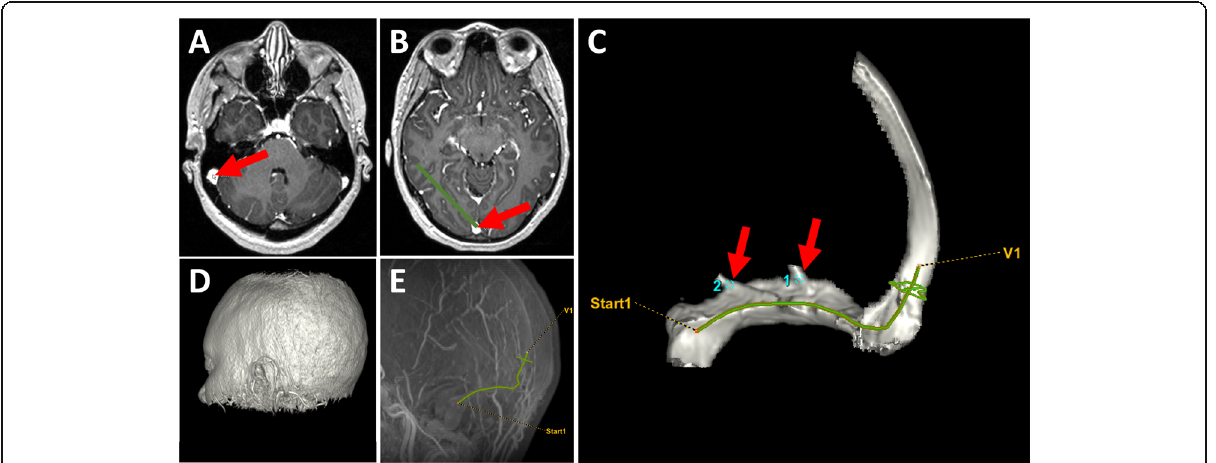
Fig. 1 3D Vessel Model. The selection of the start and end points for extraction in the sigmoid sinus and superior sagittal sinus can be seen in a and b , respectively. The resultant 3D VR vessel model with 2 points of interest (labelled 1 and 2) and the skull model, which is used to register the MRV model with fluoro, are pictured in c and d . A sagittal 3D MIP of the venous anatomy with the vessel trace highlighted in green and the start and end points defined can be seen in e